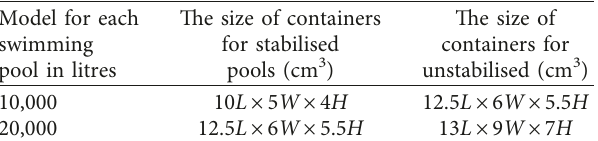
Table 2: The size of the containers of swimming pool. Model for each